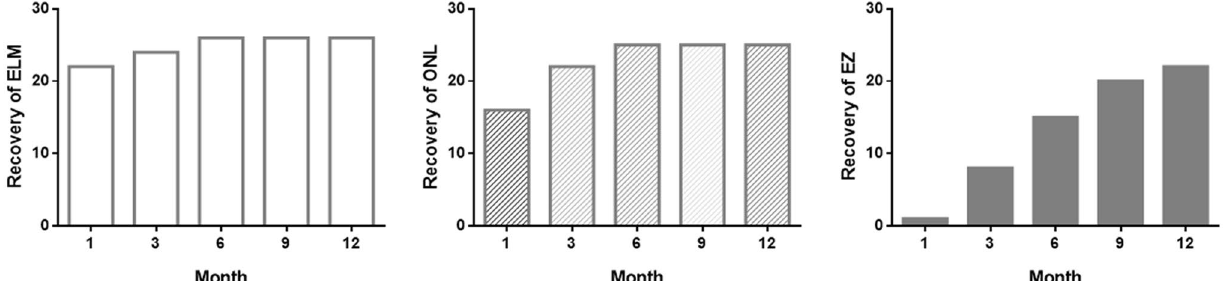
Figure 2. Recovery of the external limiting membrane (ELM), outer nuclear layer (ONL), and ellipsoid zone during follow-up. Cases with an intact ONL had an intact ELM at each visit, and cases with an intact EZ had an intact